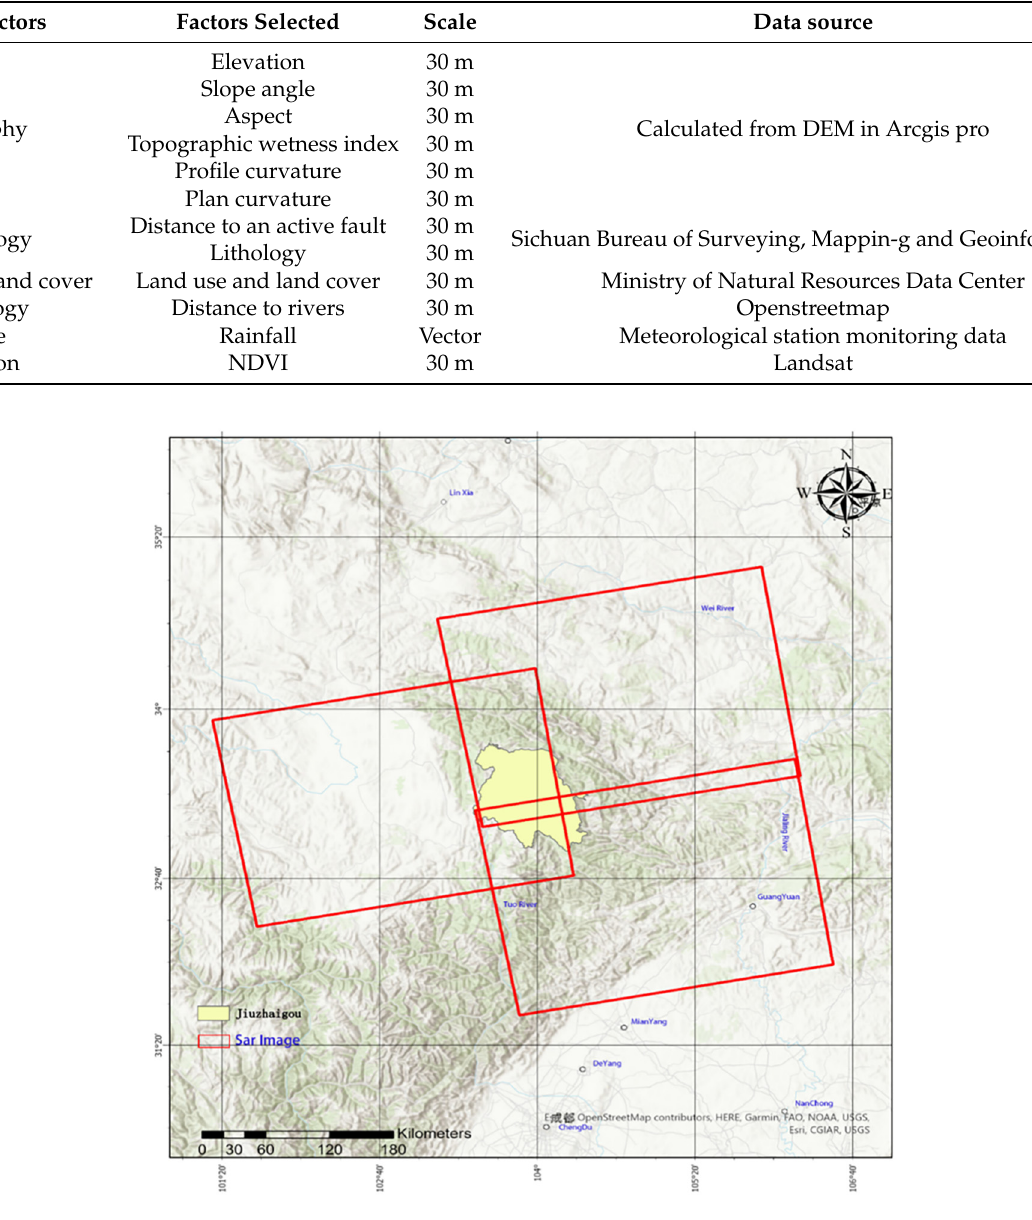
Figure 1. Jiuzhaigou area and SAR images.